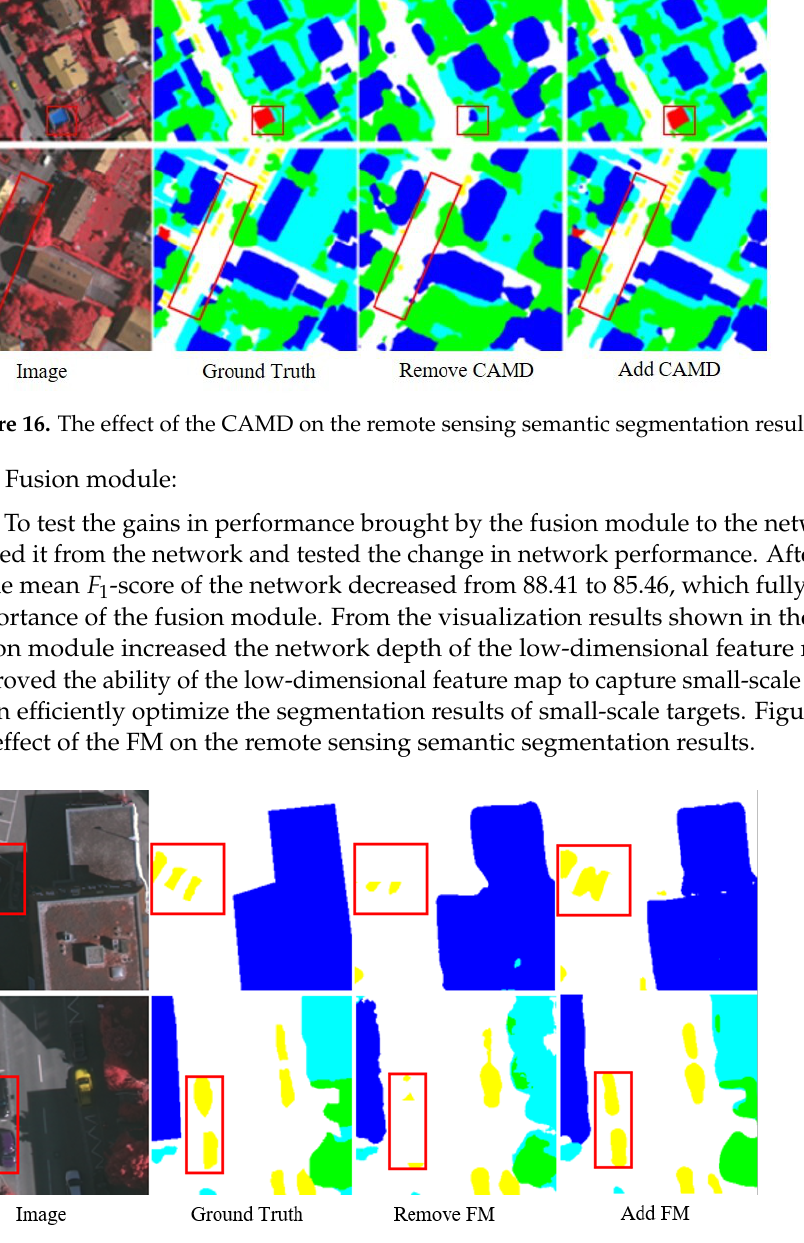
Figure 17. The effect of the FM on the remote sensing semantic segmentation